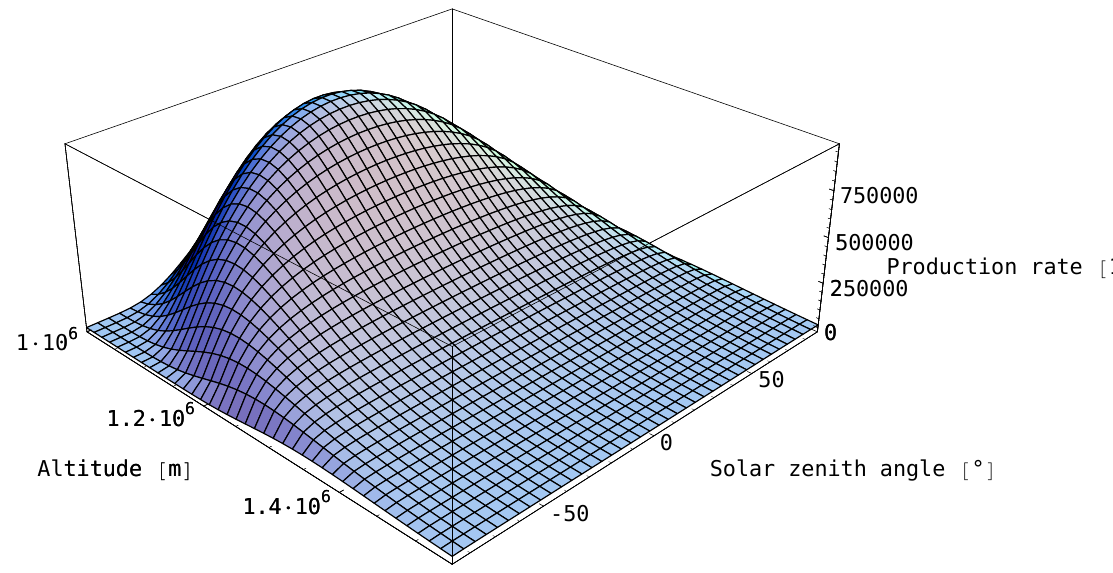
Fig. 3. Ion production rate of molecular nitrogen as a function of altitude and solar zenith angle. The production function is given by Eq. (14), the numerical values used to generate the profile can be found in Table